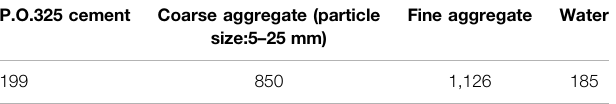
TABLE 1 | Mixture ratio of C10 concrete (unit: